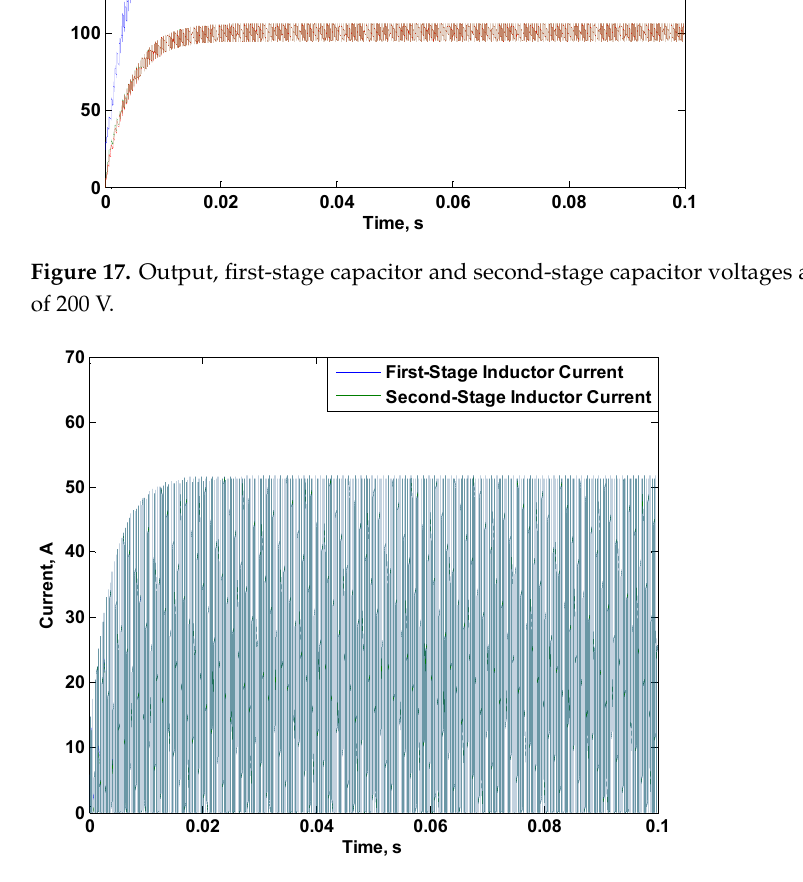
Figure 18. First-stage and second-stage inductor currents at a reference voltage of 200 V.